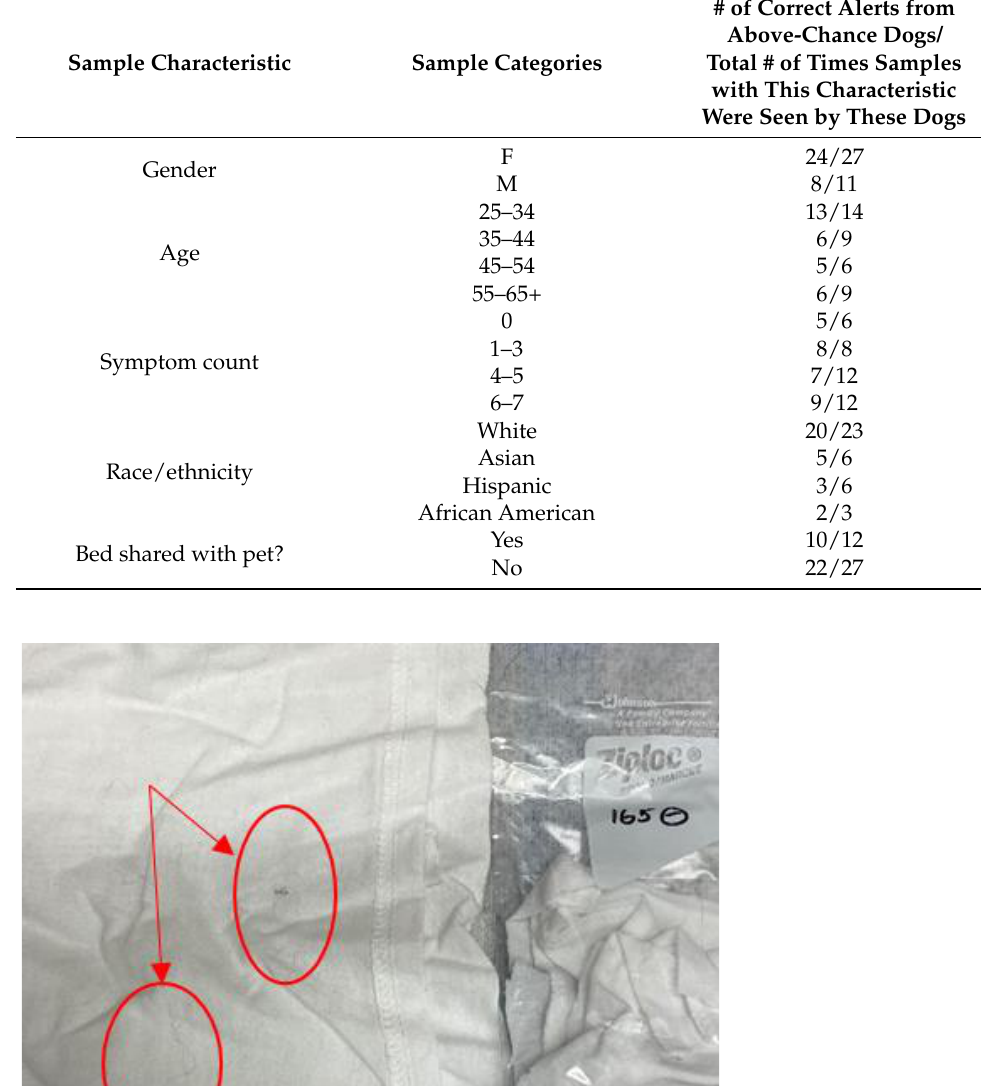
collection and the earliest and latest test done with the